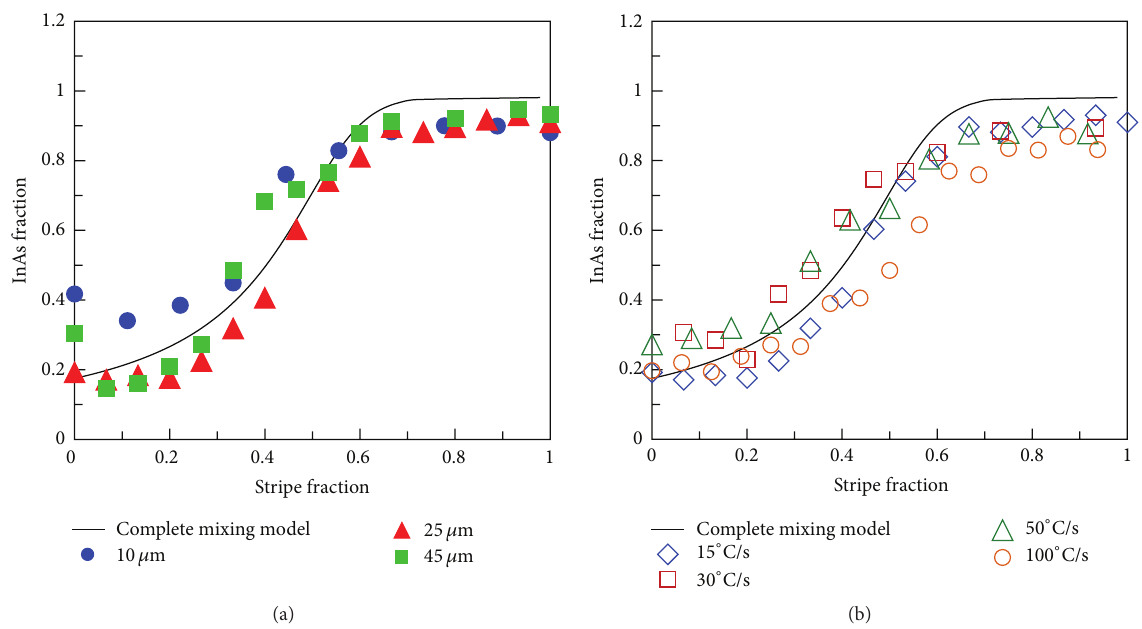
Figure 3: Plots of experimental data and model. (a) shows the InAs composition versus stripe fraction for different stripe length when the initial material is In 0.27 Ga 0.2 As 0.53 . (b) shows the InAs composition versus stripe fraction for different cooling rate when the initial material is In 0.27 Ga 0.2 As 0.53 .